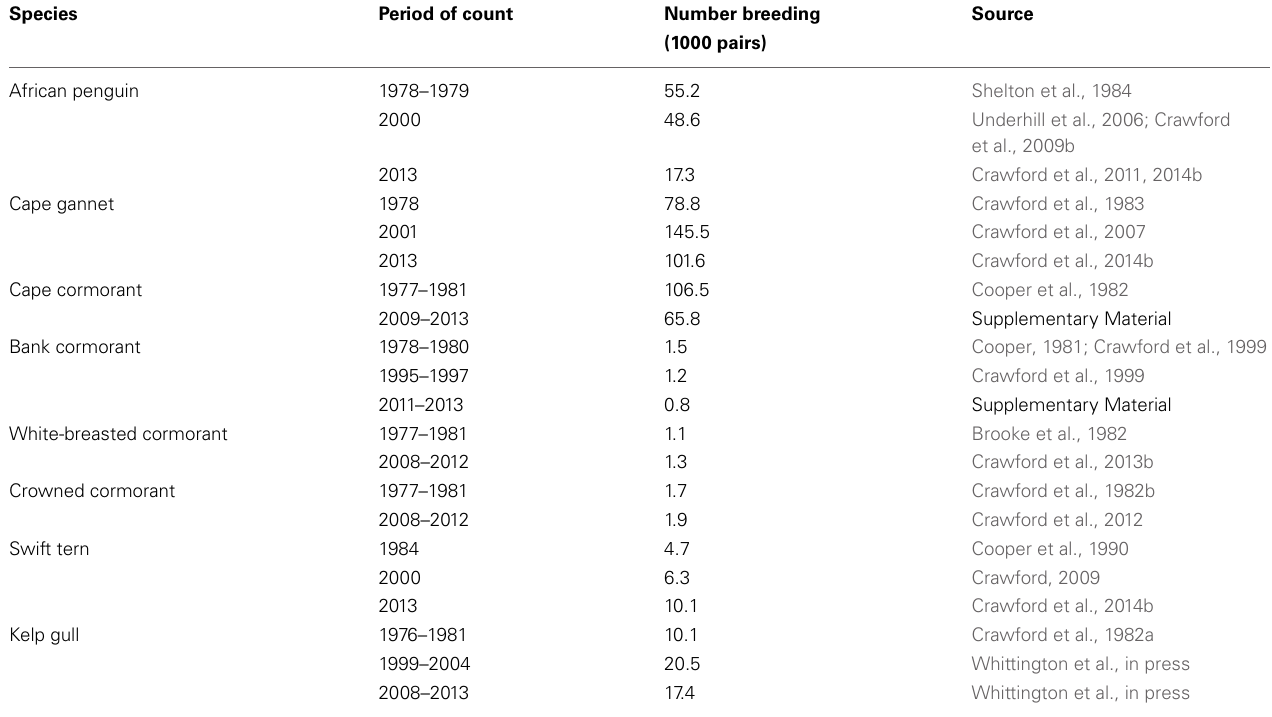
Table 1 | Overall numbers of eight seabirds breeding coastally in South Africa’s Northern, Western and Eastern Cape provinces during the